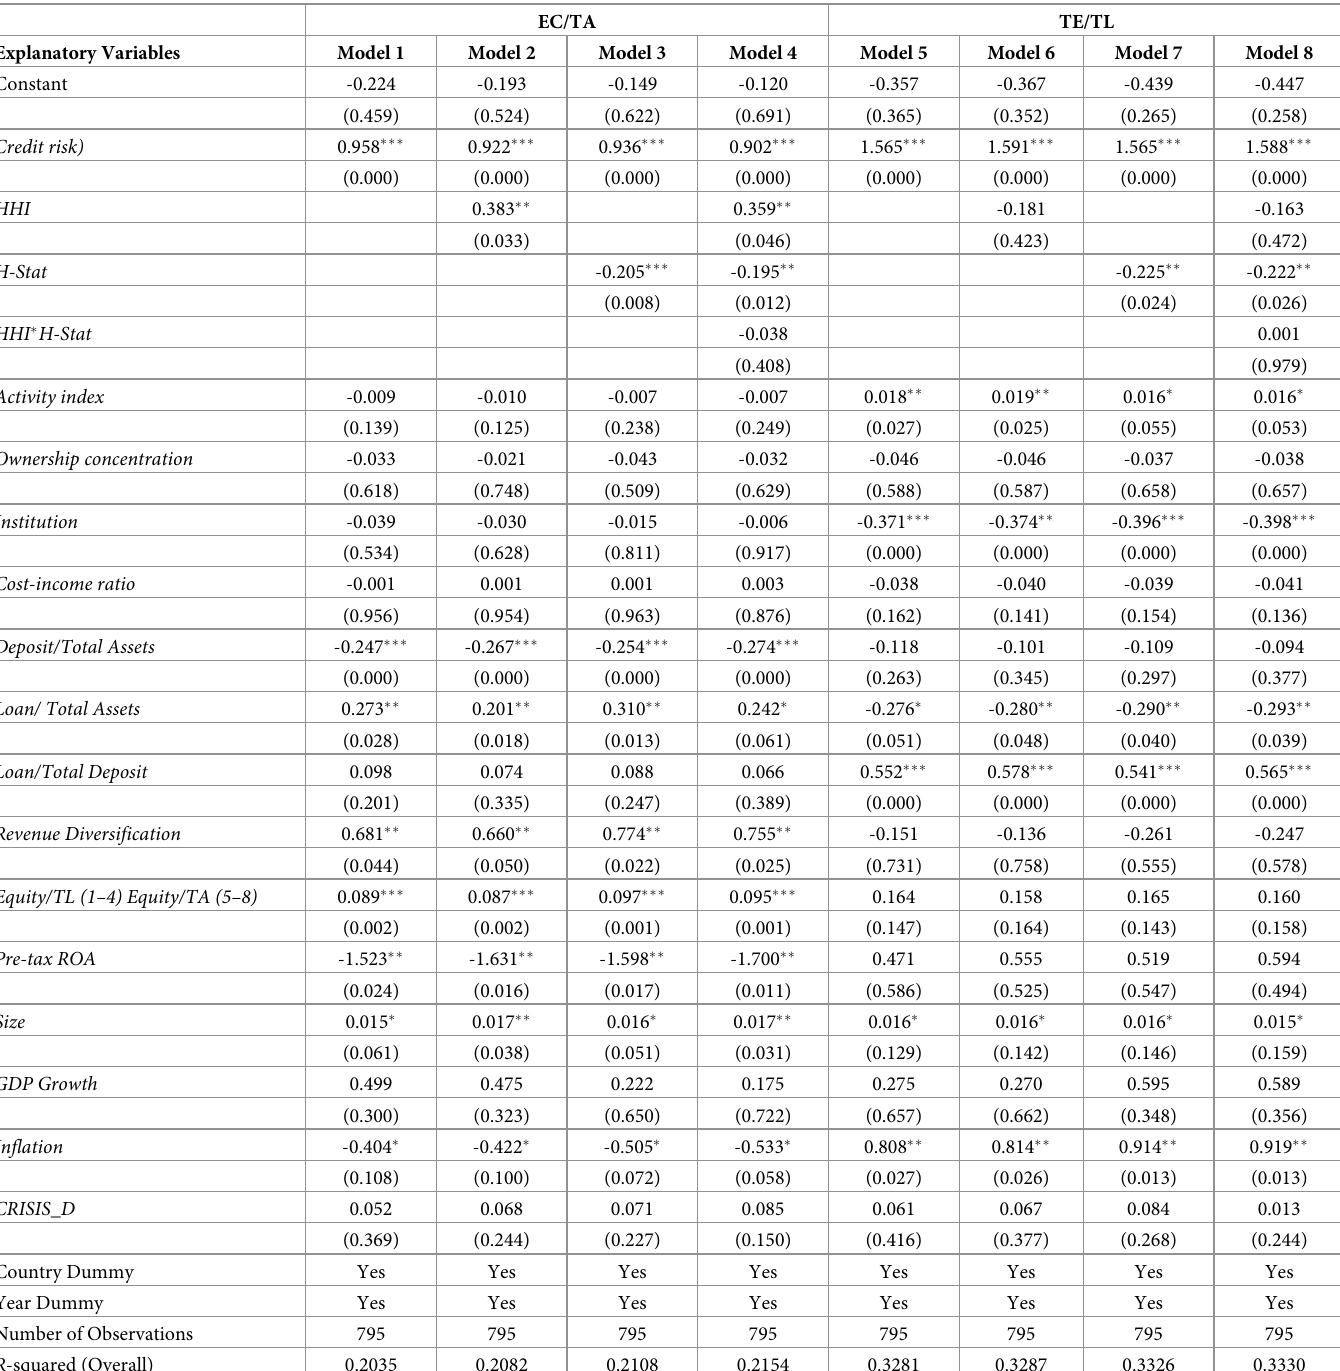
Table 5. Panel regressions of competition and capital ratio (IBs,